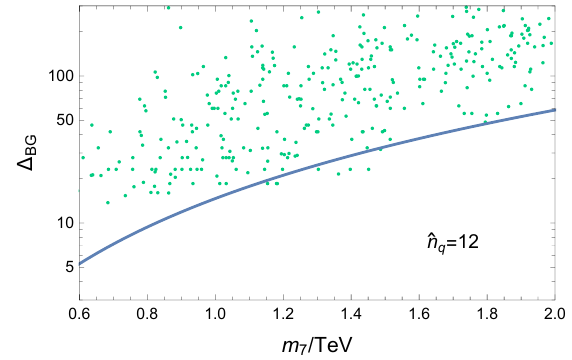
Figure 3 . Tuning (5.1) as a function of m 7 for ˆ n q = 12 , for the parameter space points with SNR. Parameters are varied within the following ranges: m and µ = 3 TeV. Blue line shows the analytic approximation of eq. (5.4).